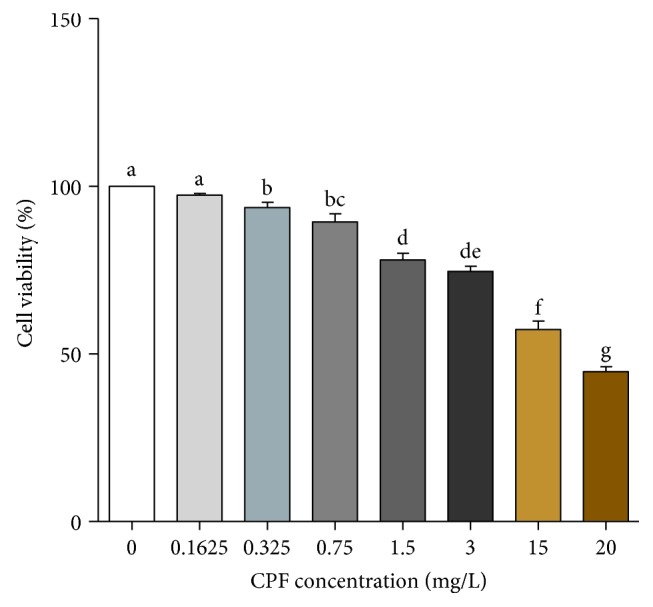
The inhibitory effects of CPF on neutrophils. Neutrophils were treated with various concentrations of CPF for 2 h. Quantitative data are presented as the mean ± SD. Samples with different letters were considered significantly different (P < 0.05). The samples with the same letters were not significantly different (P > 0.05). The LC50 for CPF-treated neutrophils was approximately 18.85 mg/L. We selected 0.325 mg/L as the optimum concentration corresponding to 95% viability of neutrophils.